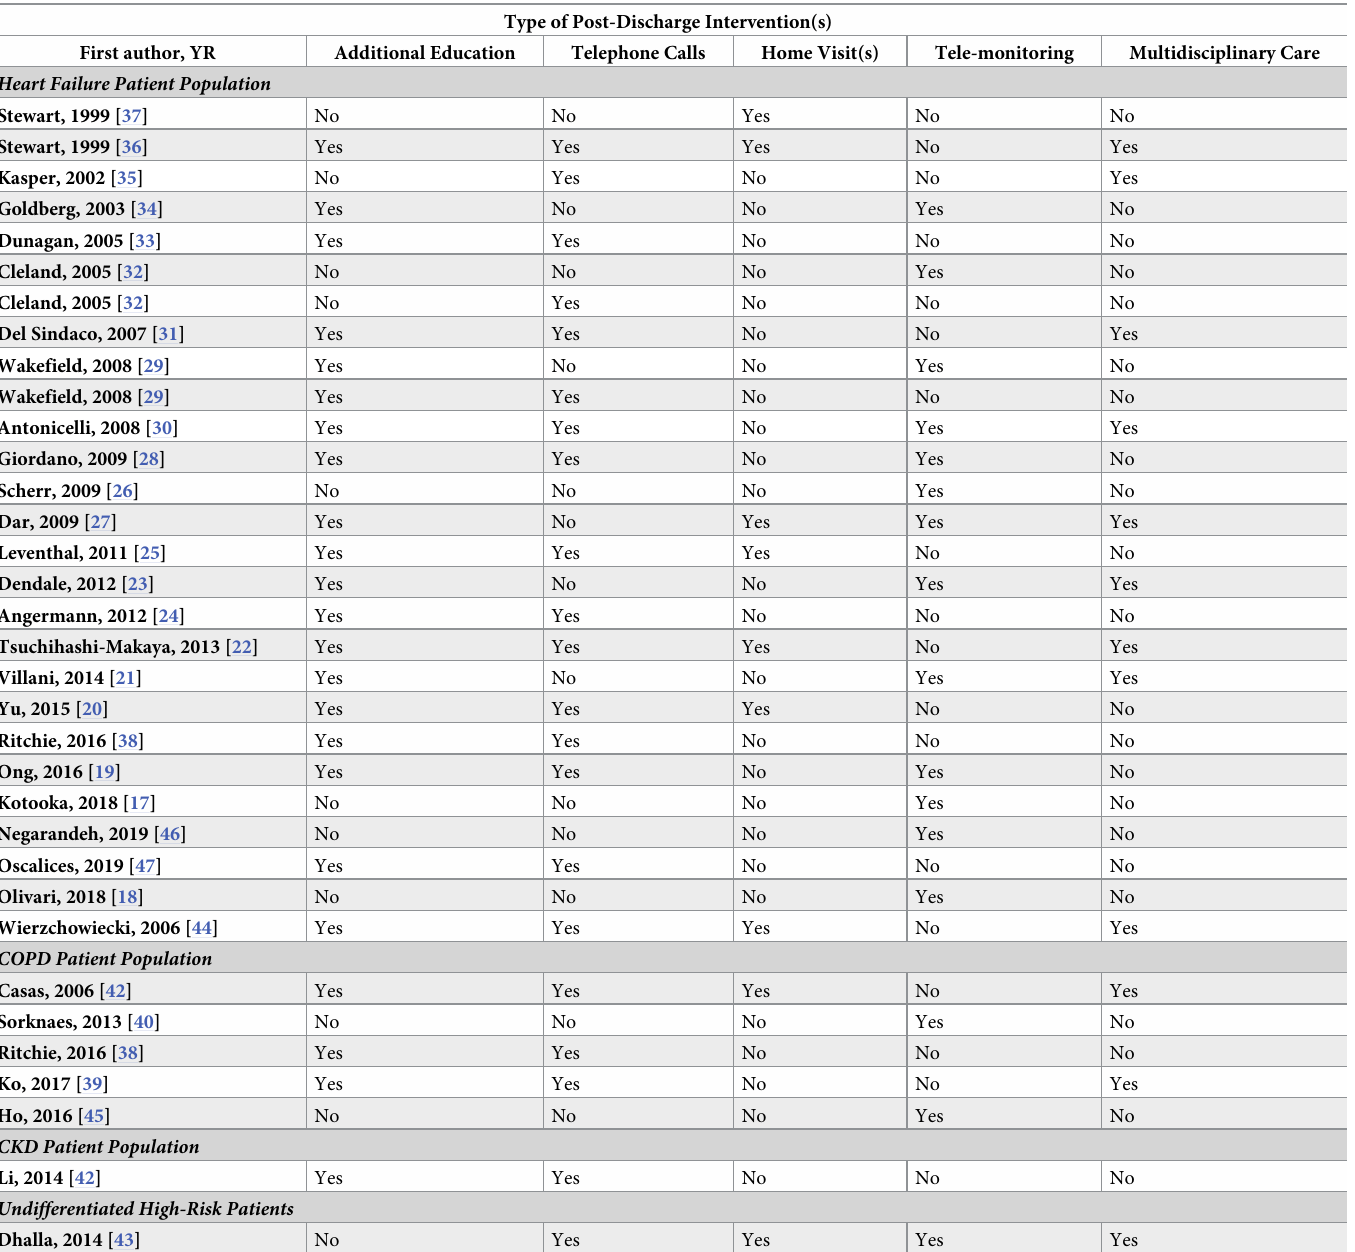
Table 2. Post-discharge interventions in included